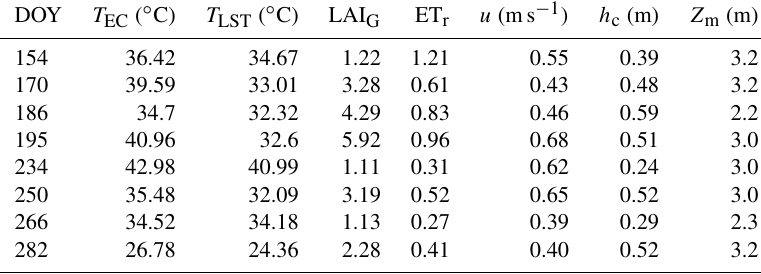
Table 6. Input parameters used for the METRIC model for the alfalfa crop. DOY T EC ( ◦ C) T LST ( ◦ C) LAI G ET r u (ms − 1 ) h c (m) Z m (m)